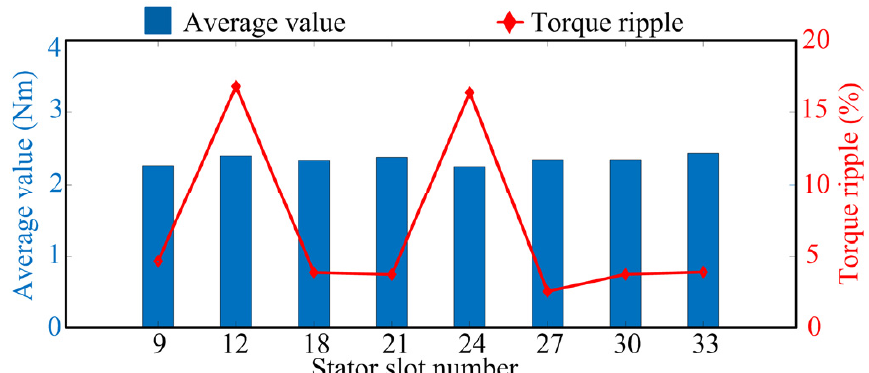
Figure 5. The average value and torque ripple of electromagnetic torque under different numbers of stator slots when the number of rotor poles is 4.